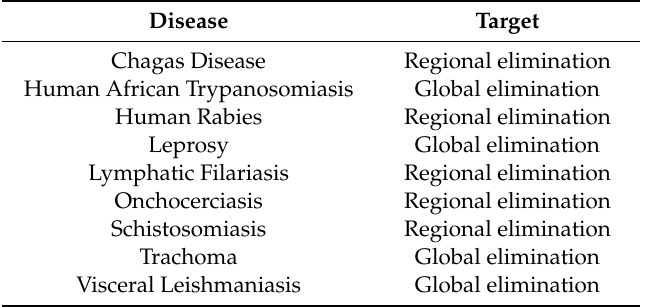
Table 1. Neglected Tropical Disease (NTD) elimination targets [3] (p.